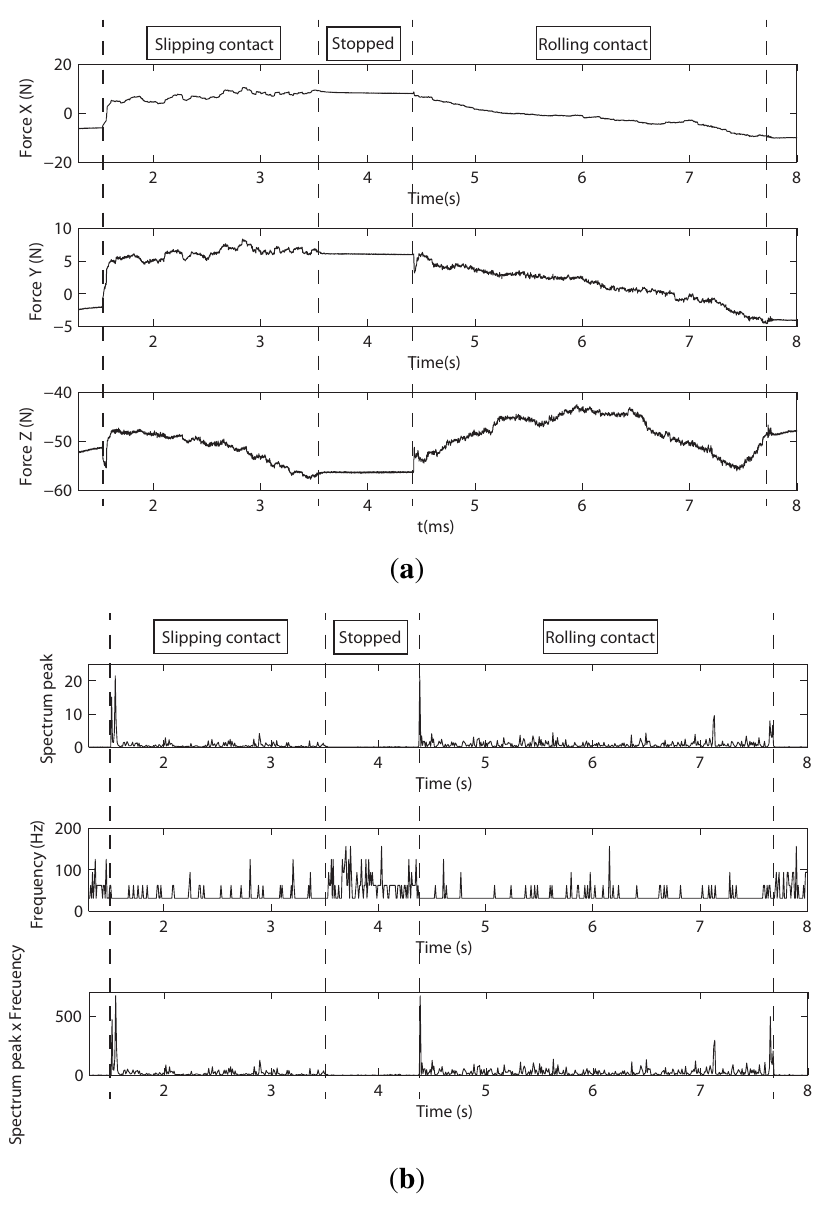
Figure 17. ( a ) The forces in sensor JR3 as a function of time; ( b ) spectrum peak and its frequency on F as a function of z